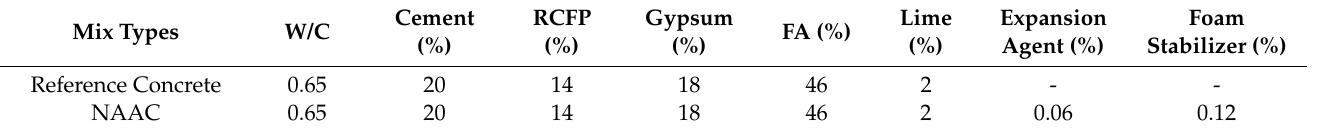
Table 4. Mix proportions of each